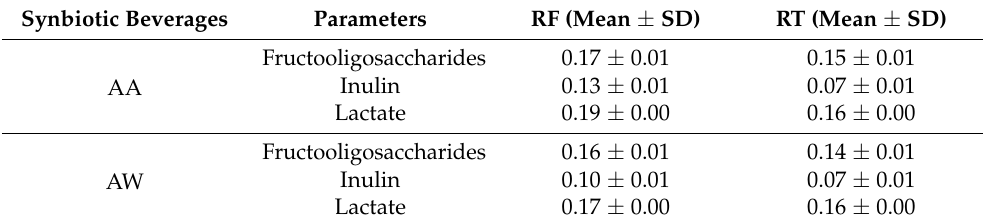
Table 10. Prebiotic composition of the synbiotic beverages after